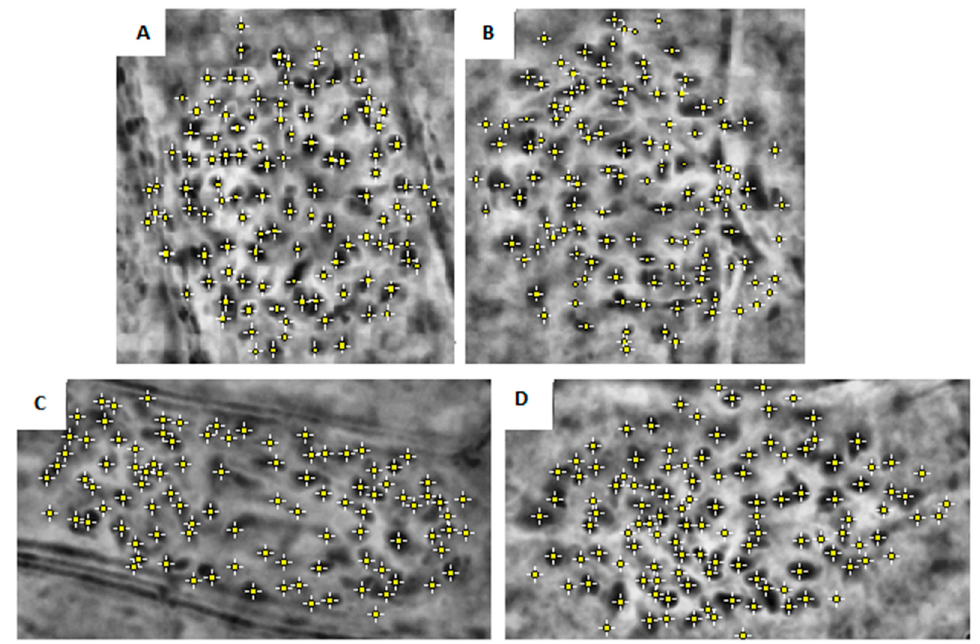
Figure 1. Chromosome counting in four giant reed clones: ( A ), Piccoplant; ( B ), Fondachello; ( C ), Martinensis; ( D ), Granadensis.